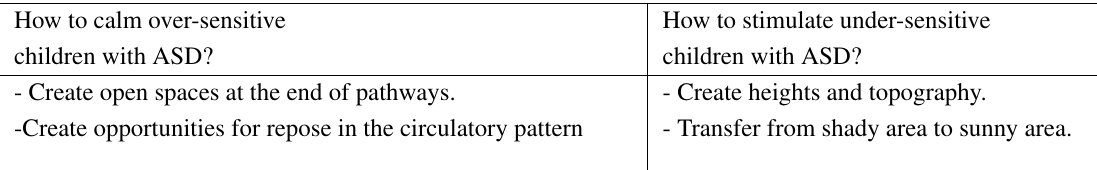
Table 12. How to use circulation in creating specific influences (Wilson, 2006)